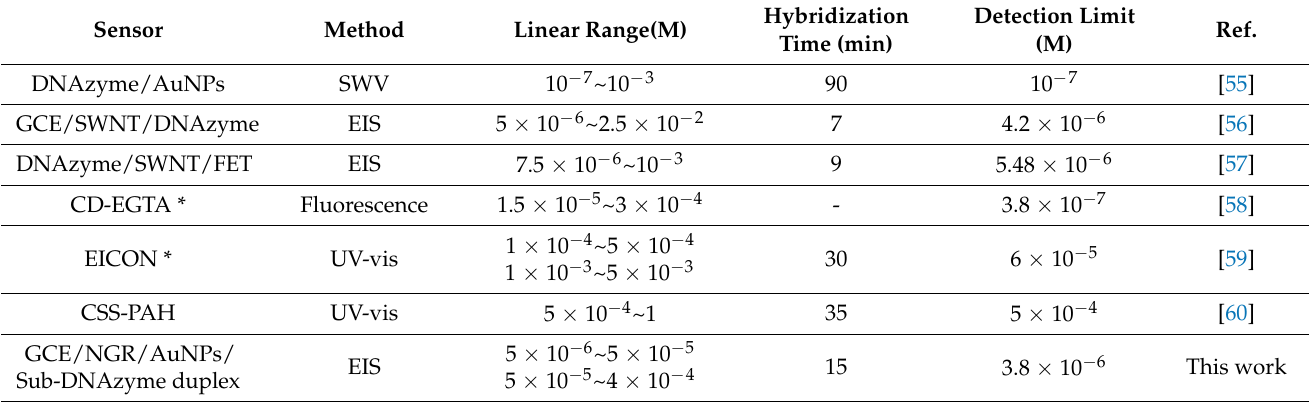
Table 2 lists the detecting parameters of Ca 2+ by different biosensors. Most DNAzyme- modified sensors have a similar linear range. Although the linear range of the electro- chemical device (GCE/NGR/AuNPs/Sub-DNAzyme duplex) developed in this paper was narrower than that of some sensors and the detection limit was not low enough, for cows, the serum Ca 2+ concentration was about 1 to 1.25 mM and 250 to 300 µ M after diluting four times. Therefore, the electrochemical device didn’t need a wide linear range and a very low detection limit to detect serum Ca 2+ in dairy cows. In addition, serum Ca 2+ could be detected without complex pretreatment, and the detection time was 15 min, which was shorter than UV-vis to detect Ca 2+ , meeting the needs of practical application. Table 2. Comparison of GCE/NGR/AuNPs/Sub-DNAzyme duplex performance with other reported sensors for Ca 2+ determination.